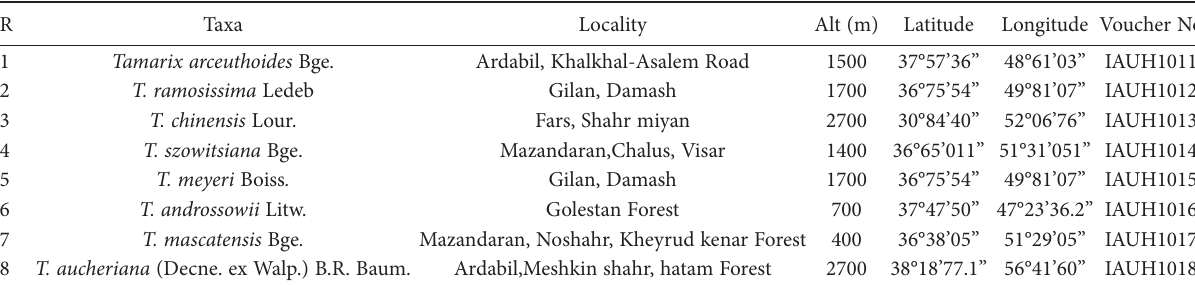
Table 1. Tamarix species and populations, their localities and voucher